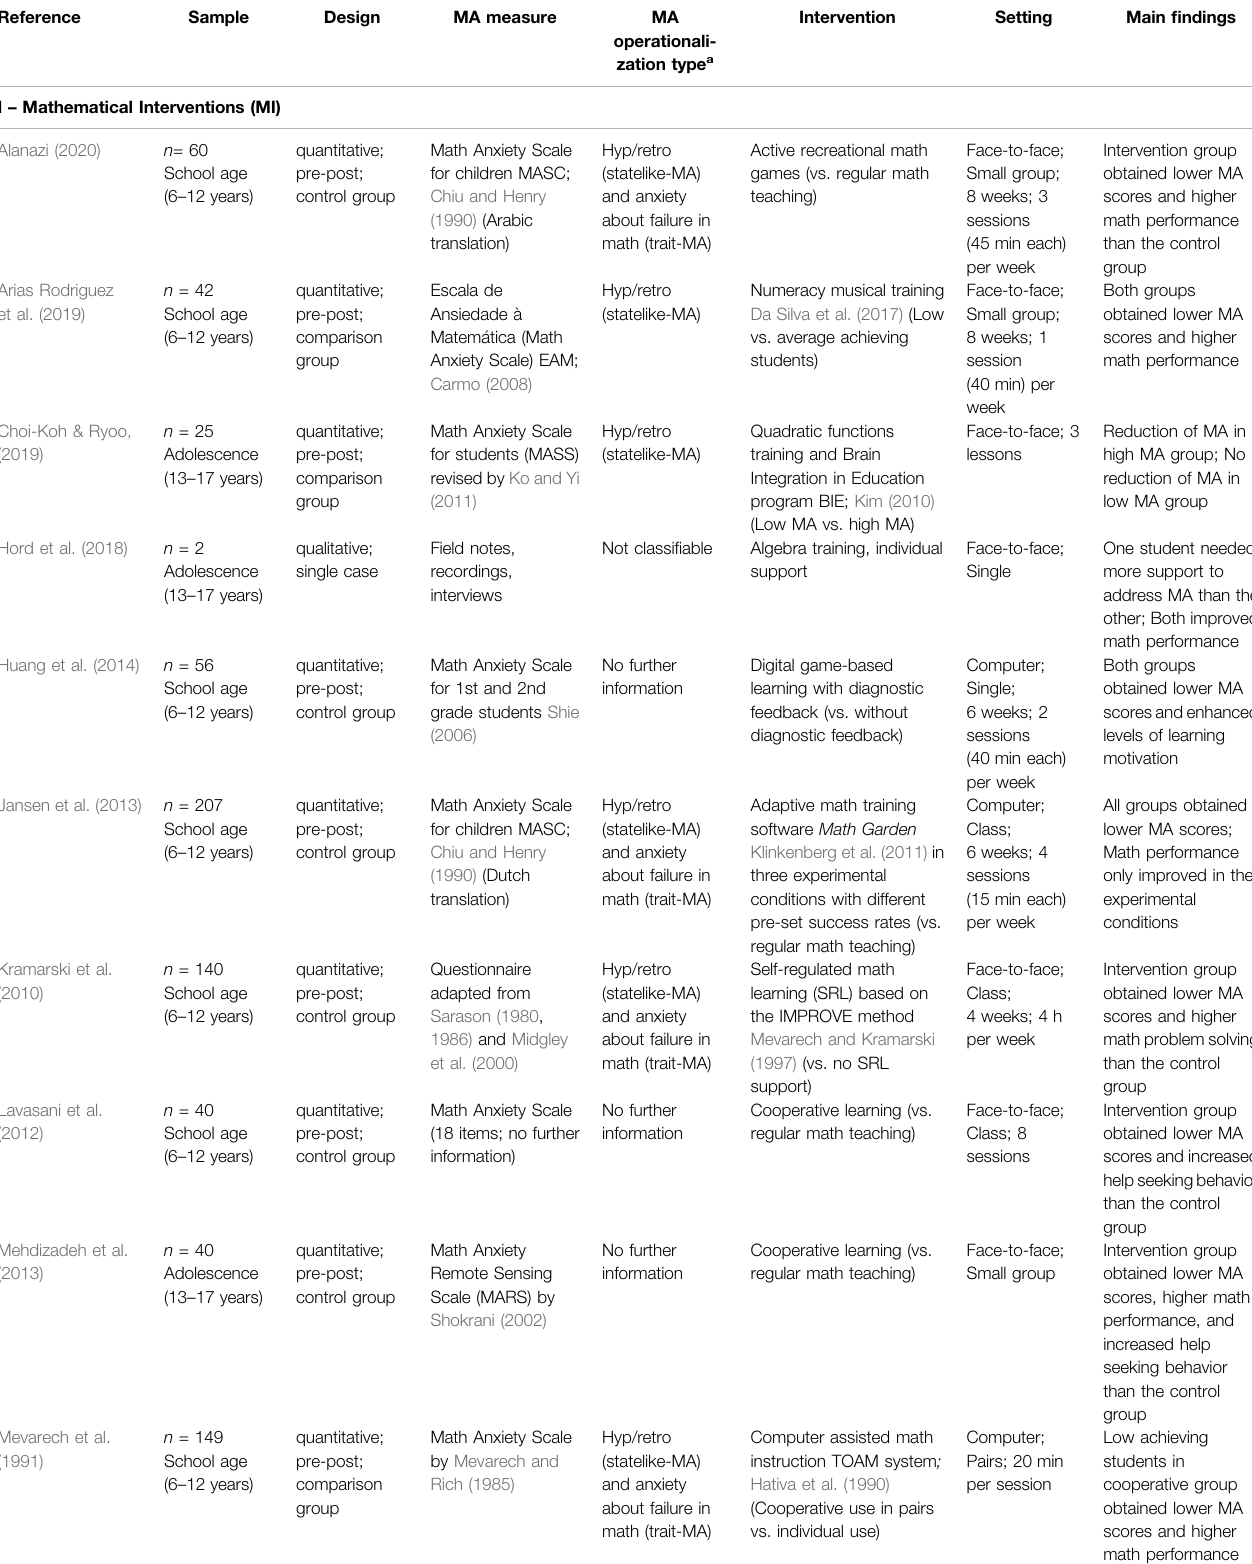
TABLE 1 | Overview of included